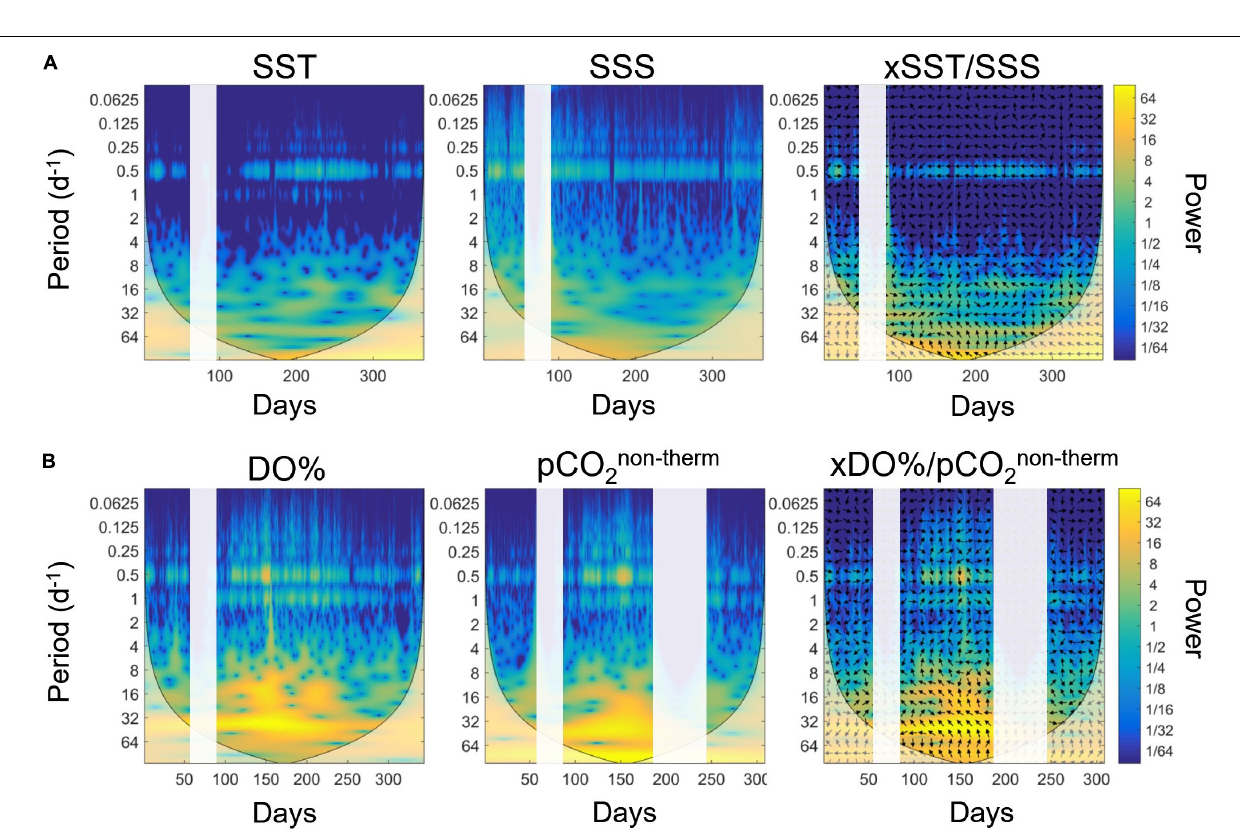
Frontiers in Marine Science |